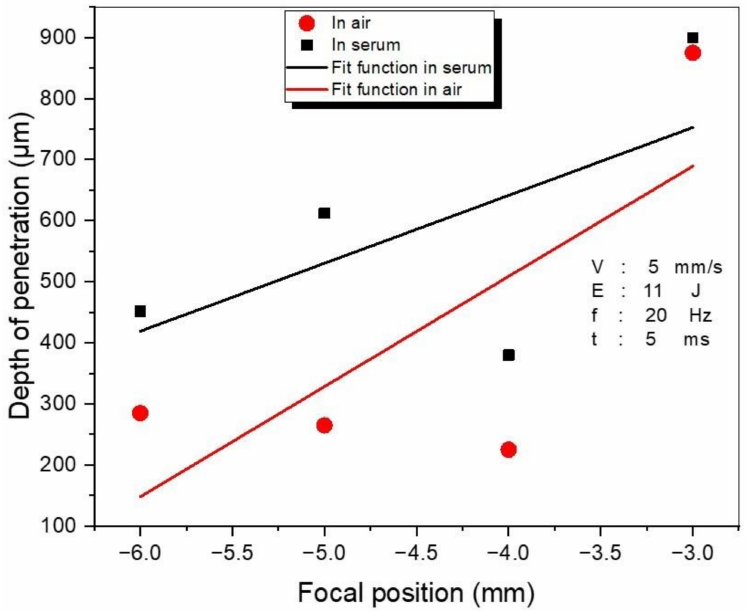
Figure 9. The variations in the penetration depth ( µ m) with focal